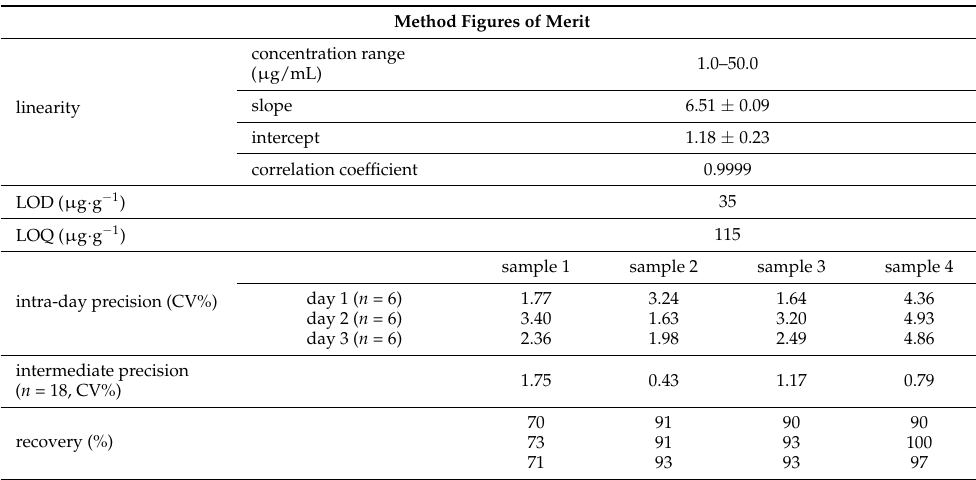
Table 2. Parameters of linearity ( n = 3), LOD and LOQ, repeatability, intermediate precision, and accuracy in terms of recovery (%) of quantitative analysis of ECD by means of